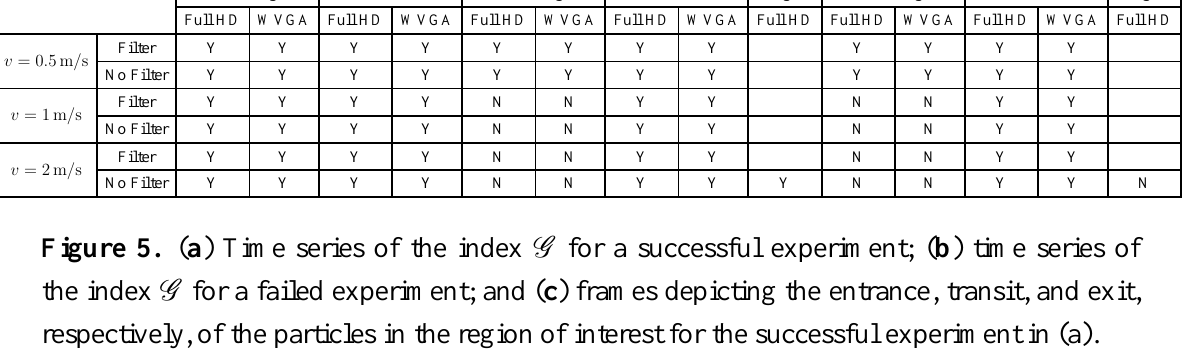
Table 1. Summary of the green-fluorescent particle experiments. H = 15cm H = 40cm H = 70cm